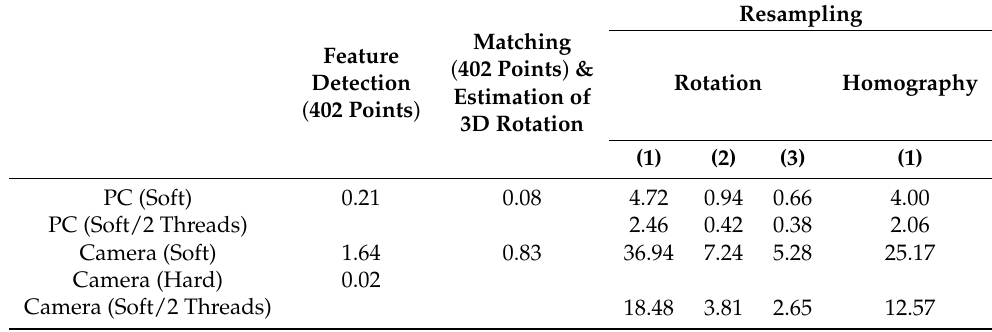
Table 2. (1) Initial geometrical transformation with bilinear interpolation; (2) accelerated geometrical transformation using the bilinear function method with bilinear interpolation; (3) accelerated geometrical transformation using the bilinear function method with nearest-neighbor resampling.